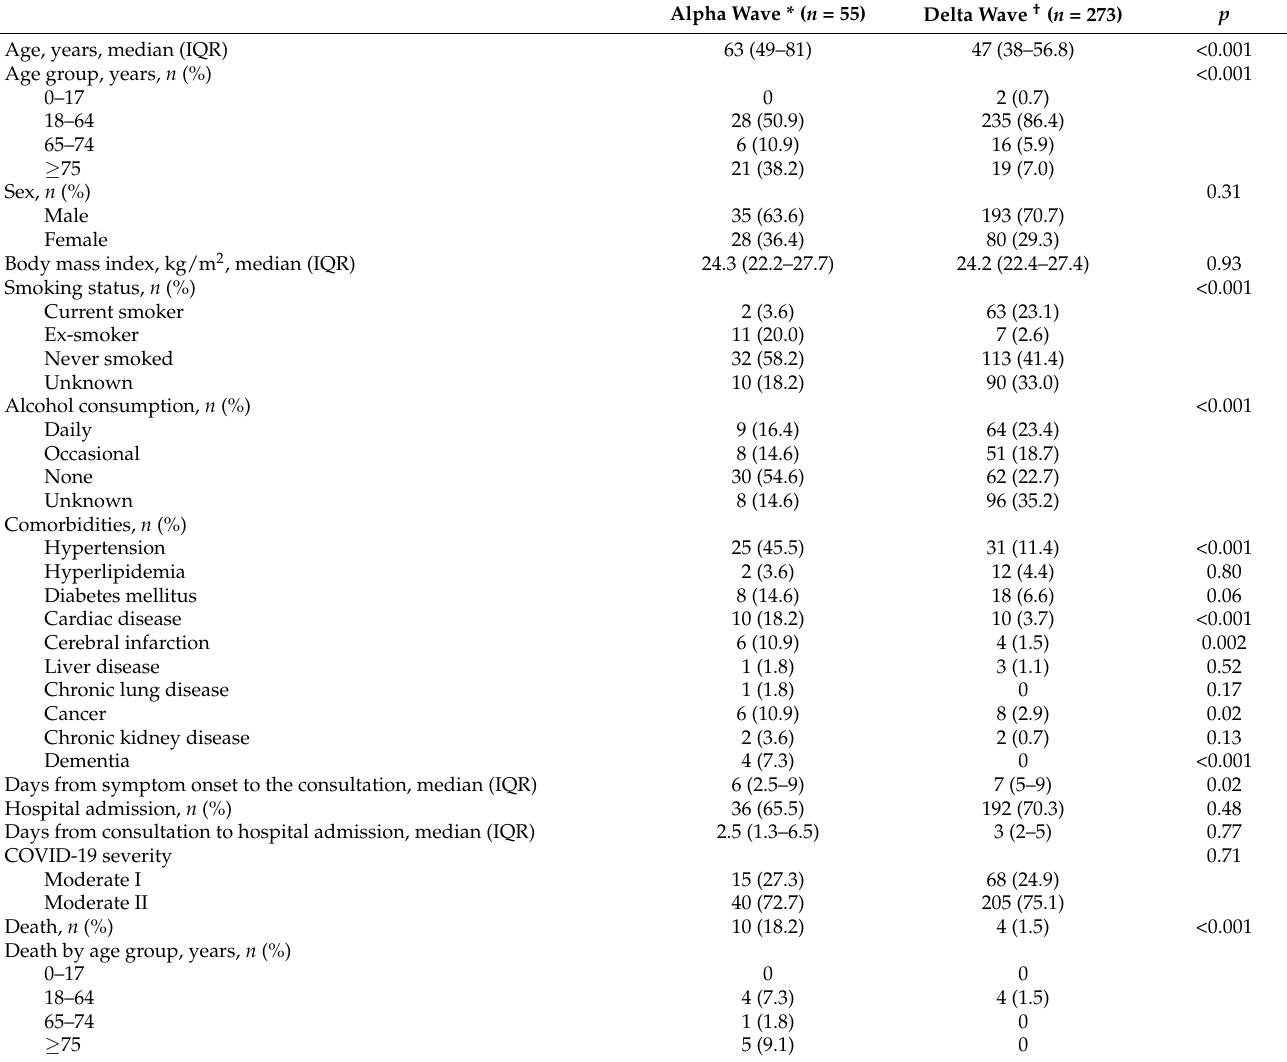
Table 1. Characteristics of the COVID-19 patients who received the after-hours home-call service while awaiting hospitalization, according to the wave of the pandemic.